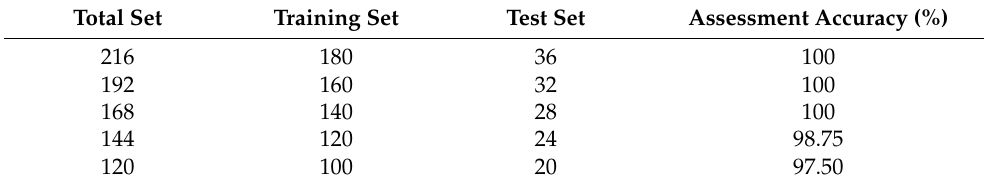
Table 8. Assessment results of different sample sizes.